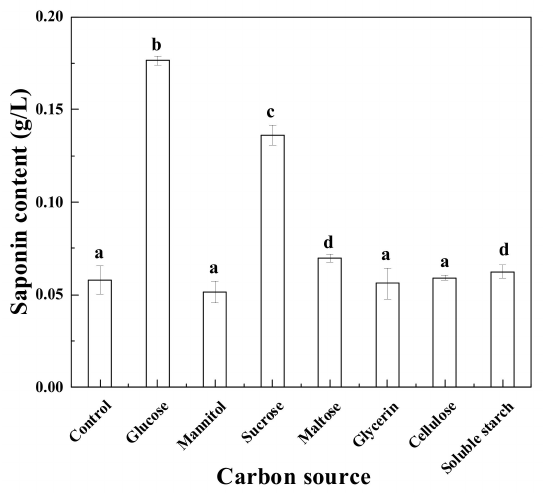
Figure 1. Effects of carbon sources on the saponin production of T. melanosporum . (Different letters on the top of column indicate significant differences between means: a, b, c, d, p <